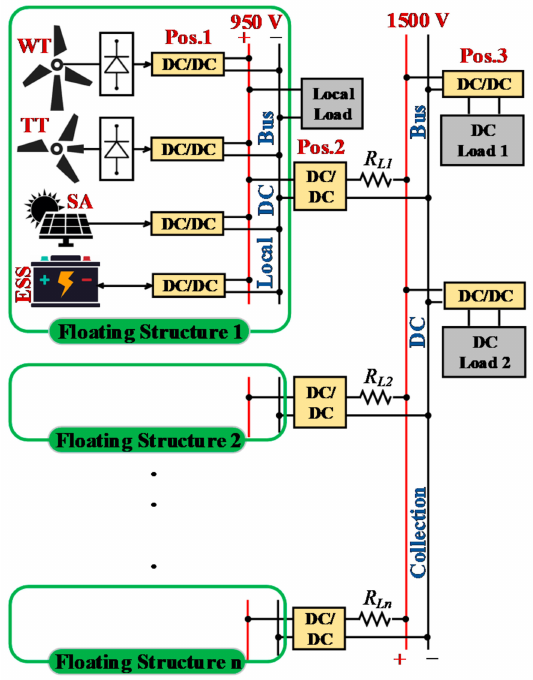
Figure 1. Configuration of an offshore Direct Current (DC) microgrid comprises n -floating energy units connected in parallel to DC collection